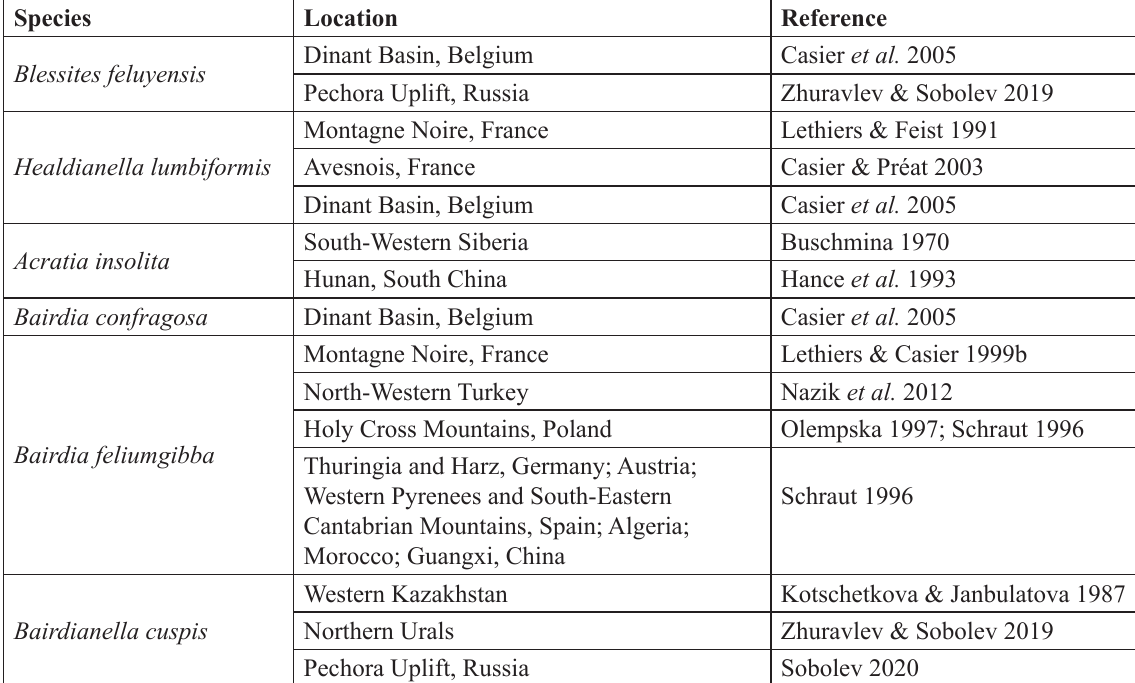
Table 5. Species absent in the Famennian of the Blue Snake section but represented in other localities